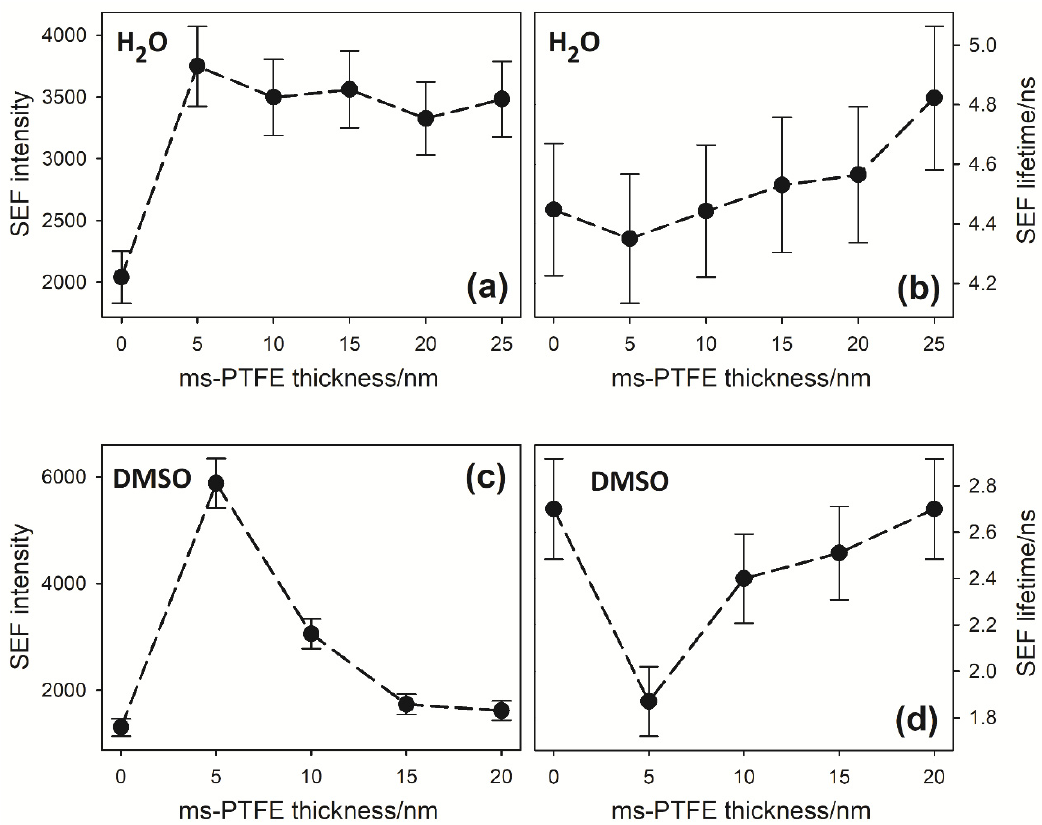
Figure 5. Fluorescence intensity ( a,c ) and lifetime ( b,d ) of riboflavin adsorbed on the SEF-active surface from a sessile droplet obtained for various thicknesses of the ms-PTFE overlay of the Ag nanoislands. Solvents: water ( a,b ) and dimethylsulfoxide (DMSO) ( c,d ). The error bars indicate the estimated precision as a standard deviation. The lines connecting the adjacent points are only a support for the eye and do not reflect the dependence of the measured quantities on the thickness of the overlay.